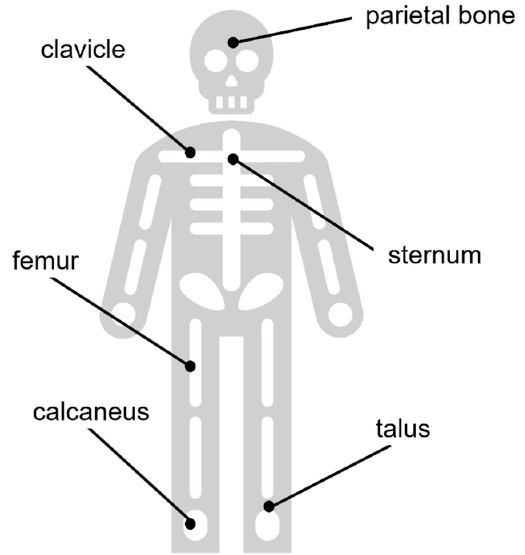
Figure A1. Explanatory graphic summarizing the approximate anatomical positions of the bone samples used in this study.